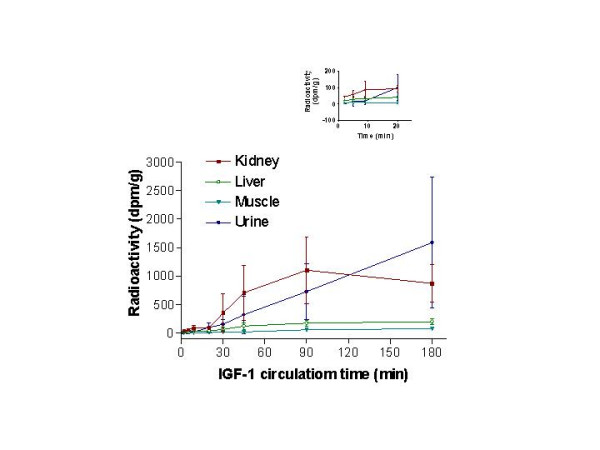
IGF-1 radioactivity in kidney, liver, skeletal muscle and urine after its intraventricular injection. Kidneys were always seen to preferentially sequester IGF-1 from blood in the first 90 min after injection. Appreciable amounts of radioactivity began to appear in the urine after an initial lag period of ~5 min. After 20 min, radioactivity in urine rose almost linearly with time whereas that in the kidneys began dropping after 90 min. Liver and skeletal muscle had comparatively very little radioactivity throughout the period of study. The inset shows the tissue radioactivity for the first 20 min that may not be evident on the main graph. All data are mean ± SD at the various times.